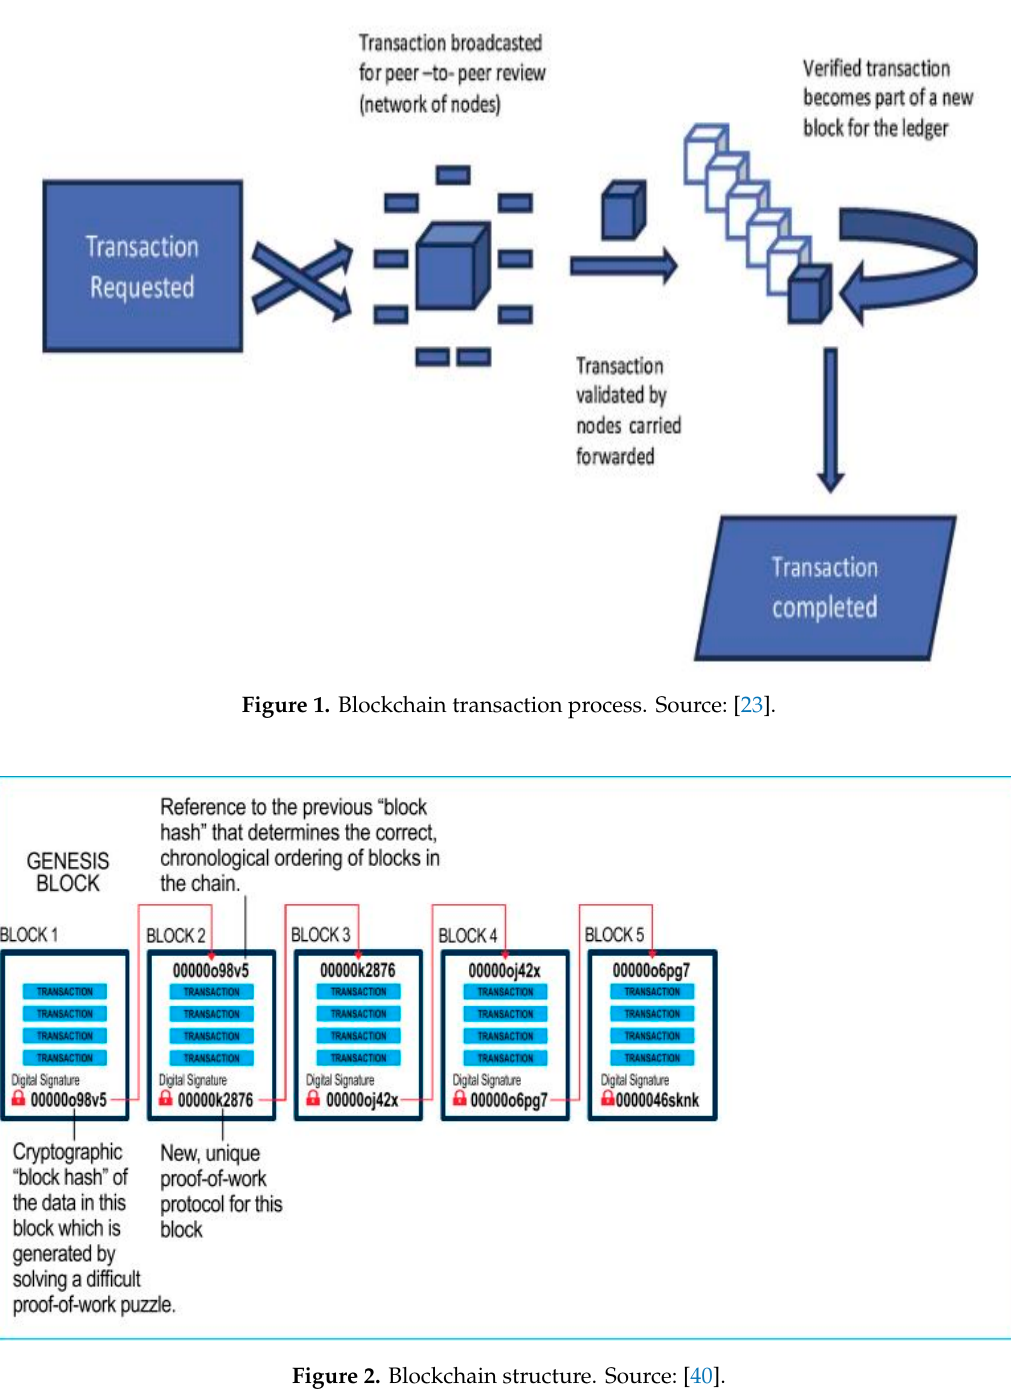
Figure 2. Blockchain structure. Source: [40].